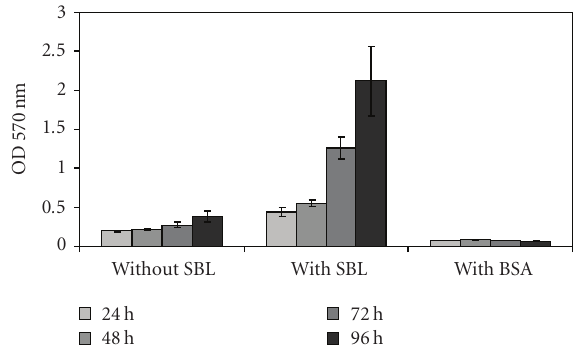
Figure 2: Optical density at 570 nm indicating biofilm formation in the microtiter plate assay by B. japonicum USDA 110 in the presence of the indicated concentrations of purified SBL, after 24- hours incubation.